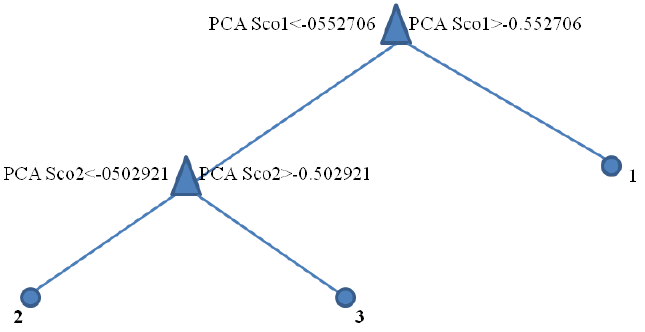
Figure 3. Classification tree of the dataset obtained without thermal desorption. Results from other analytical protocols (thermal desorption pre-treatment at four different temperatures) were similar and are omitted for